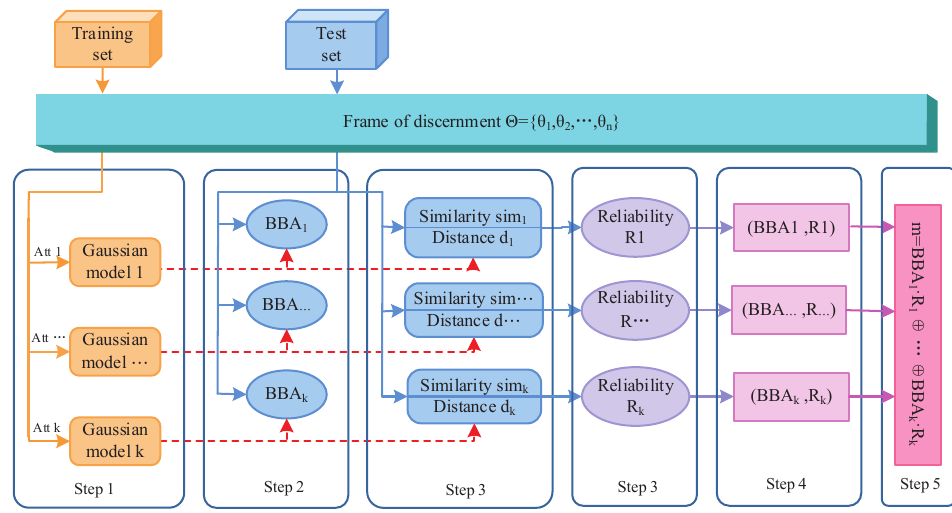
Figure 1. Flowchart of the proposed